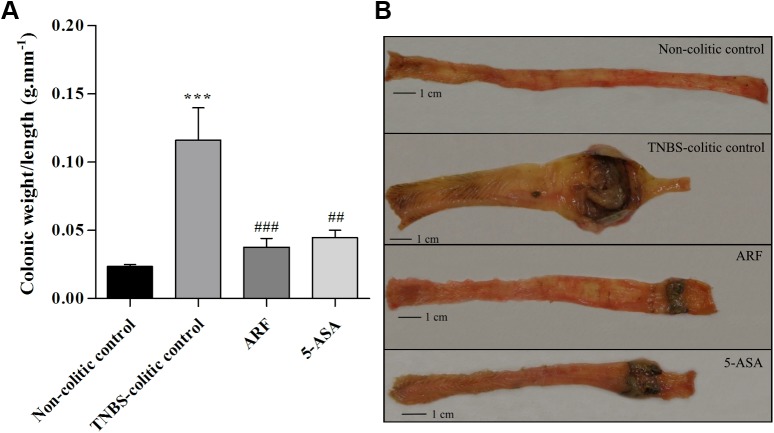
Effect of anthocyanin-rich fraction, as compared with 5-ASA, on the colon weight/length ratio of TNBS-induced colitic rats.On day 8, post TNBS-induced colitis, the colon of each animal was excised and evaluated in terms of weight and length. The colon weight vs length ratio for each group of animals is represented in graph A. Representative images of typical colons of each group are also shown (B). Values are mean ± SEM of at least 8–9 animals per group. ***P<0.001 vs non-colitic control; ##P<0.01, ###P<0.001 vs TNBS-colitic control.